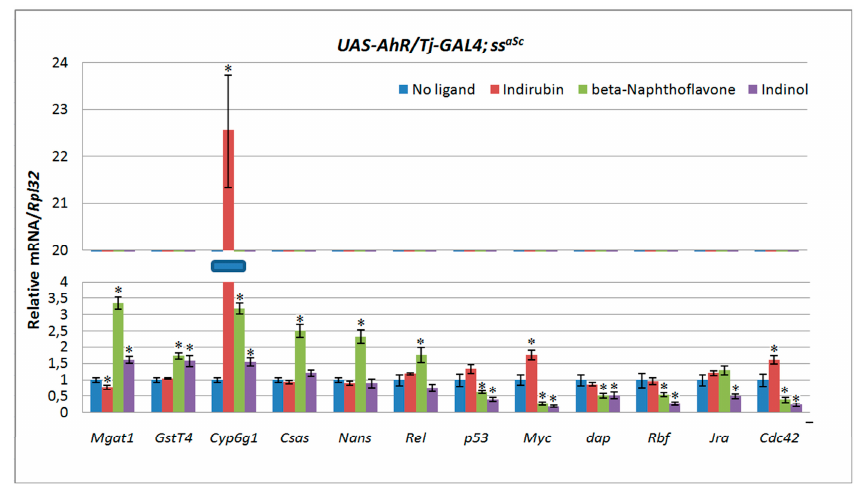
Figure 4. Decreased expression of CG5017 nucleotropic chaperone leads to ligand dependent activation in transcription of some AHR target genes. Relative mRNA levels were analyzed by real-time PCR in testes dissected from UAS-AhR/Tj-GAL4 ; ss aSc flies fed with indirubin, beta-Naphthoflavone or indinol for 2 days. UAS-AhR/Tj-GAL4; ss aSc flies developed on standard medium were used as a control. Transcript levels are represented as means ± SD (error bars). * p < 0.05, compared to the control. Statistical analysis was performed using Student’s t -test.